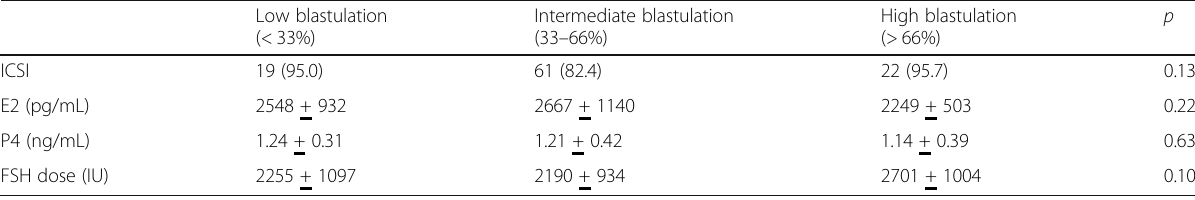
Table 4 IVF cycle characteristics for variable blastulation rates